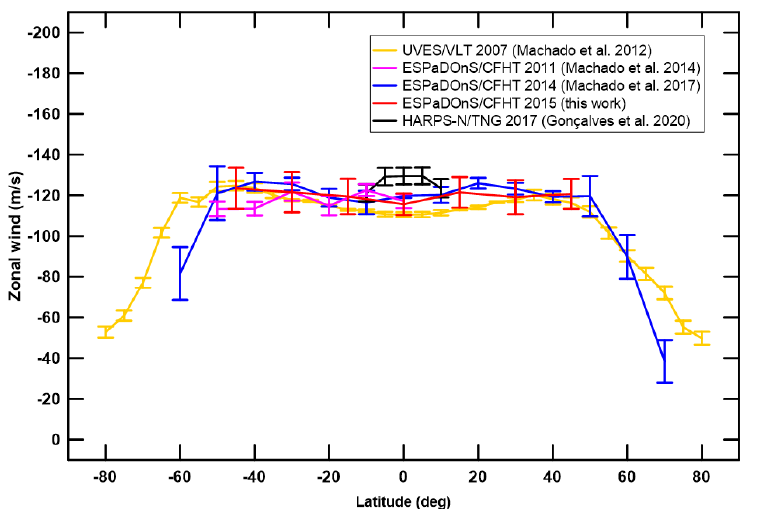
Figure 5. Comparison of zonal wind velocities obtained using the Doppler velocimetry technique throughout multiple observations campaigns—Machado et al. [26] (UVES/VLT), Machado et al. [8,10] (ESPaDOnS/CFHT) and [12] (HARPS-N/TNG).